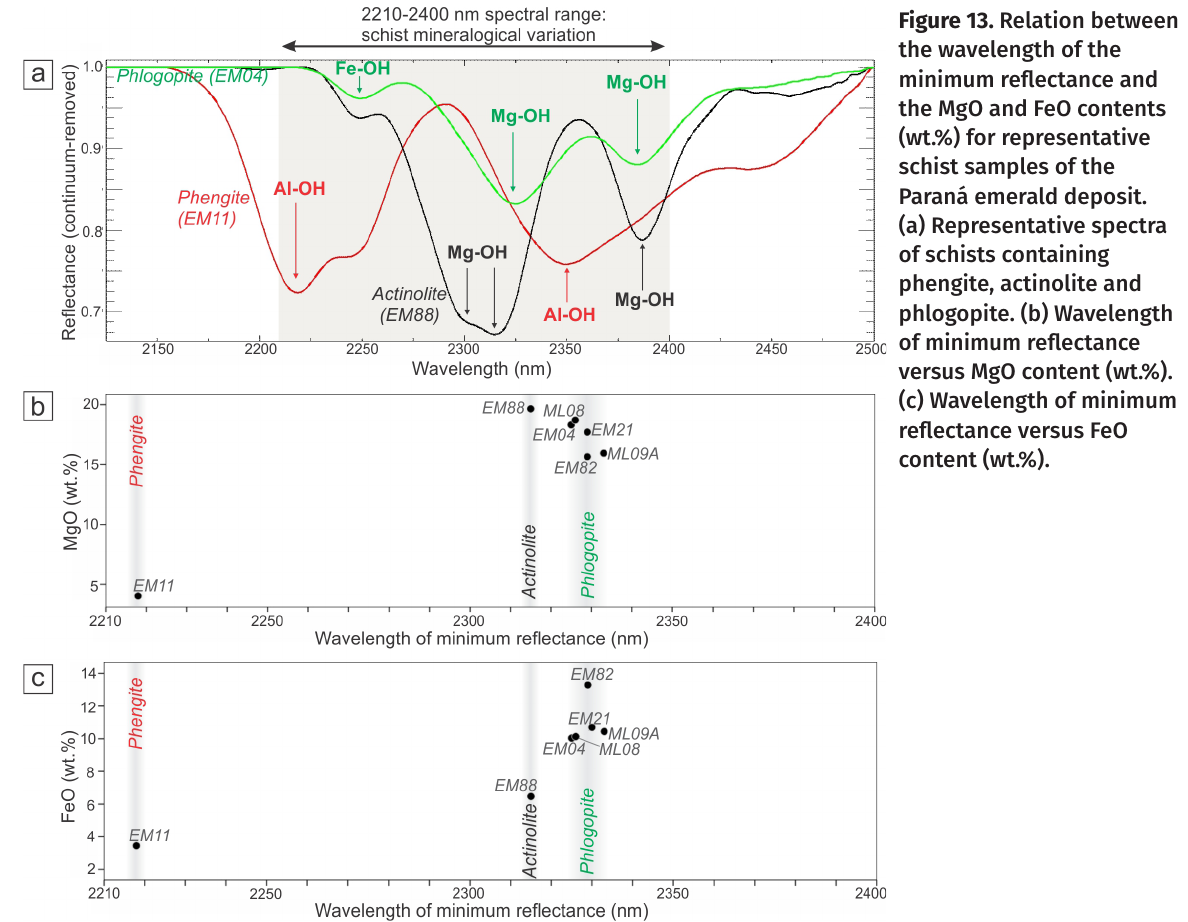
Figure 13. Relation between the wavelength of the minimum reflectance and the MgO and FeO contents (wt.%) for representative schist samples of the Paraná emerald deposit. (a) Representative spectra of schists containing phengite, actinolite and phlogopite. (b) Wavelength of minimum reflectance versus MgO content (wt.%). (c) Wavelength of minimum reflectance versus FeO content